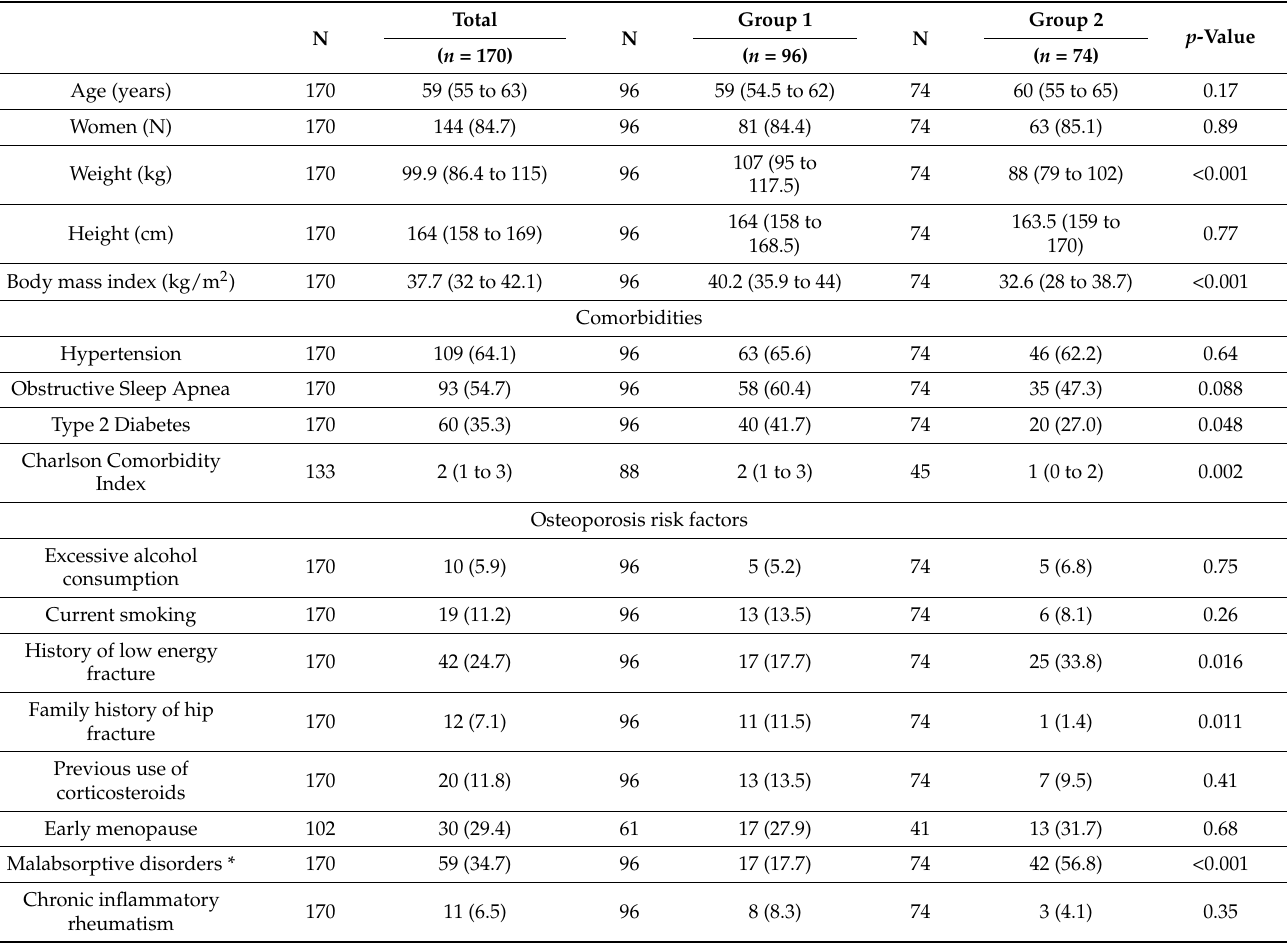
Table 1. Patients’ general characteristics at